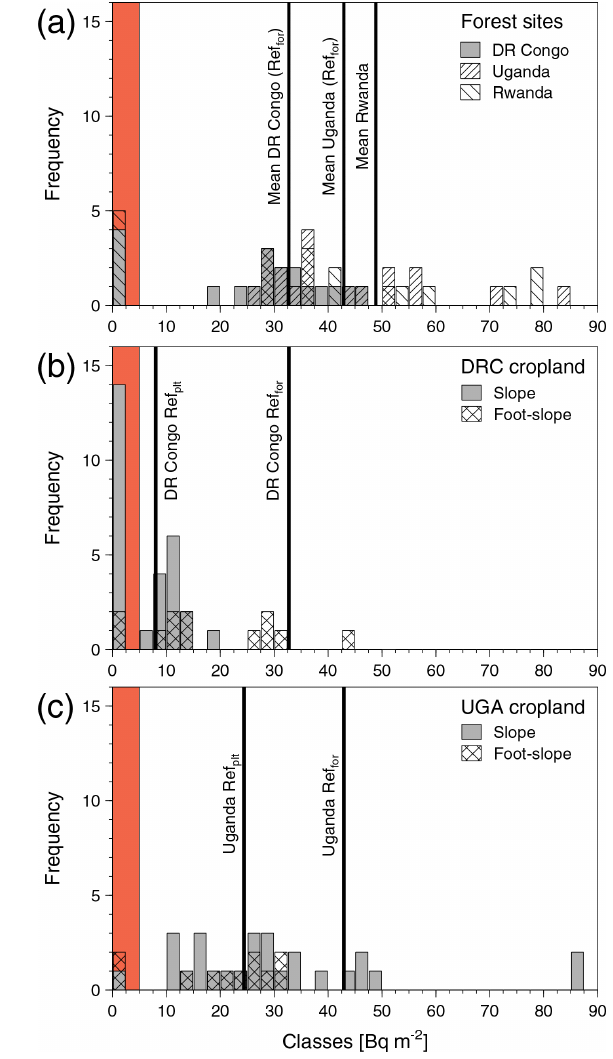
Figure 2. Distribution of 239 + 240 Pu inventories in three forests and two cropland study sites. In (a) the 239 + 240 Pu histogram for three forest sites is given, while (b) and (c) represent the cropland distri- bution at the slope and foot-slope topographic positions. The verti- cal lines represent the mean values serving as the forest reference (Ref for ) and cropland plateau reference (Ref plt ). Red section on the left of the graphs illustrates the detection